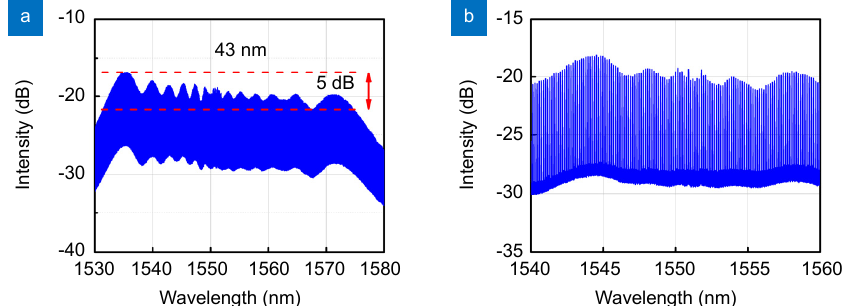
Fig. 4 | Optical spectra of the generated flat-topped OFC. ( a ) The 10 GHz repetition rate at 26.5 dBm pump power. ( b ) The 18.5 GHz repeti- tion rate at 25.5 dBm pump